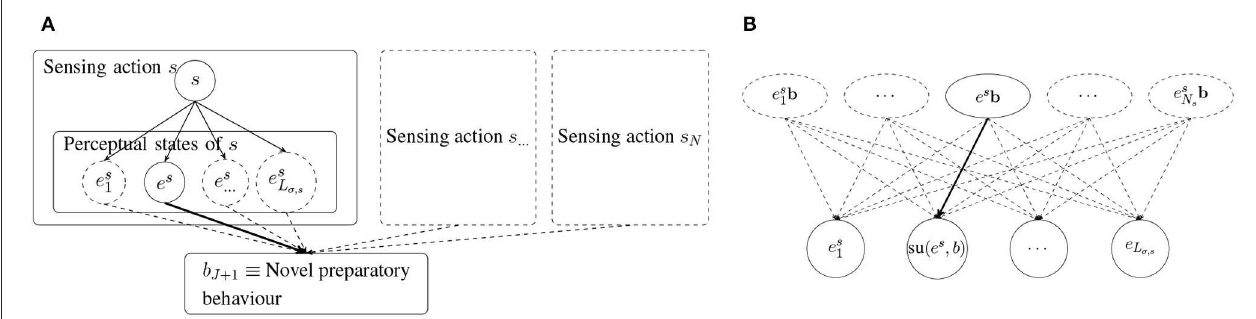
FIGURE 4 | Insertion of the novel compound behavior b J + 1 = b , generated in the current perceptual state e s ∈ E s σ , to the playing ECM of skill σ (left) (c.f. Figure 2 ), and the environment models of the used sensing behavior s ∈ S (right), respectively. (A) The behavior b J + 1 is added as child clip to all perceptual states except for the current state e s with the initial weight h init (dashed lines). In this case it is added with a higher weight proportional to the curiosity score (solid line) (c.f. Equation 22). The connections to all other preparatory behaviors are omitted in this figure. (B) All pairs ( e , b J + 1 ) of perceptual states e ∈ E s σ and the behavior b J + 1 = b are added. The weights are chosen according to Equation (23) (case 1: solid line, case 2: dashed lines). Note that case 1 only applies for the currently used sending action s ∈ S .